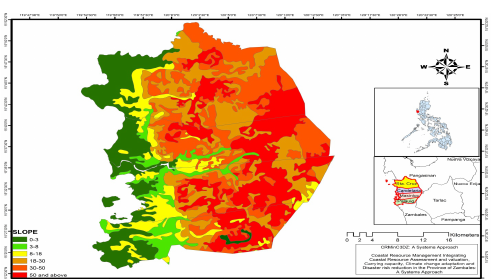
Figure 4. Slope map of the study area